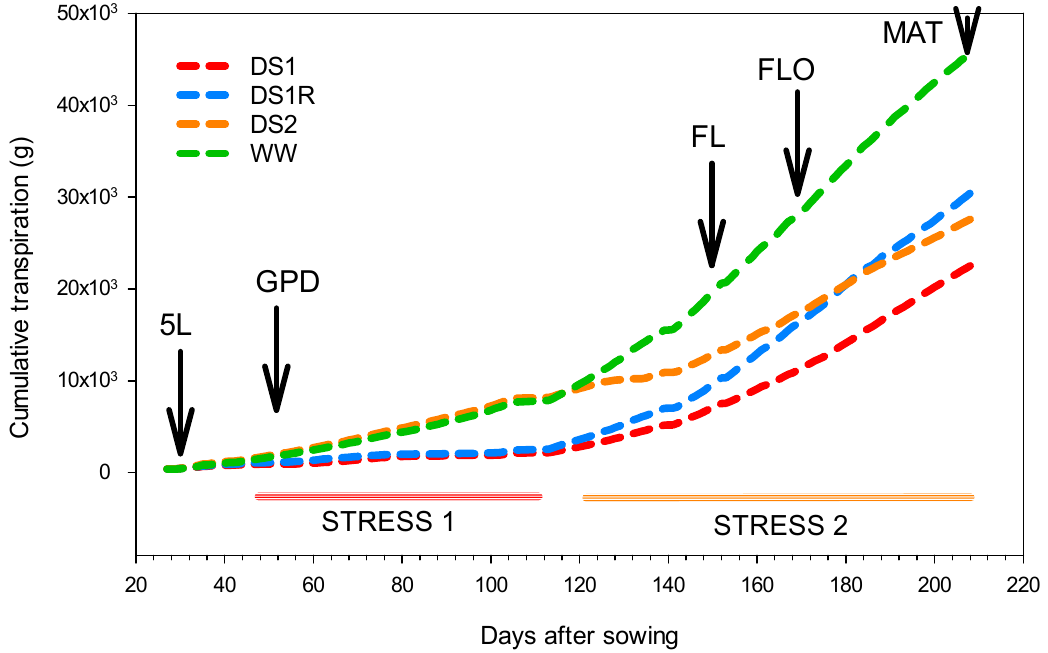
Figure 1. Cumulative transpiration compared between different water regimes. 5L: five leaf, GPD: growing point differentiation, FL: flag leaf, FLO: flowering, MAT: physiological